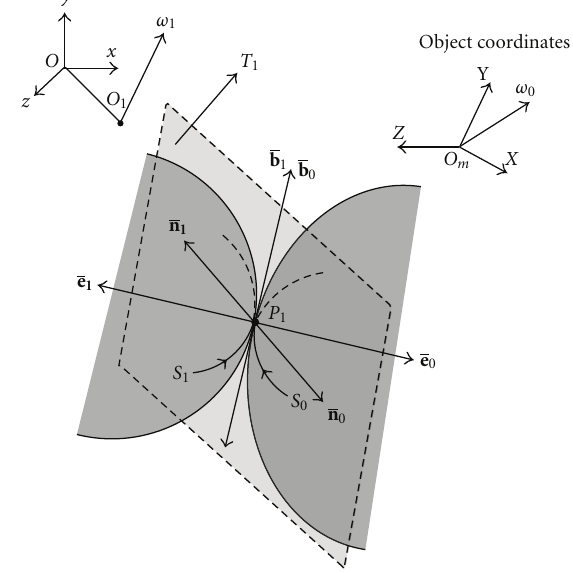
Figure 2: Definition of the moving frame coordinates system centering at the rolling contact